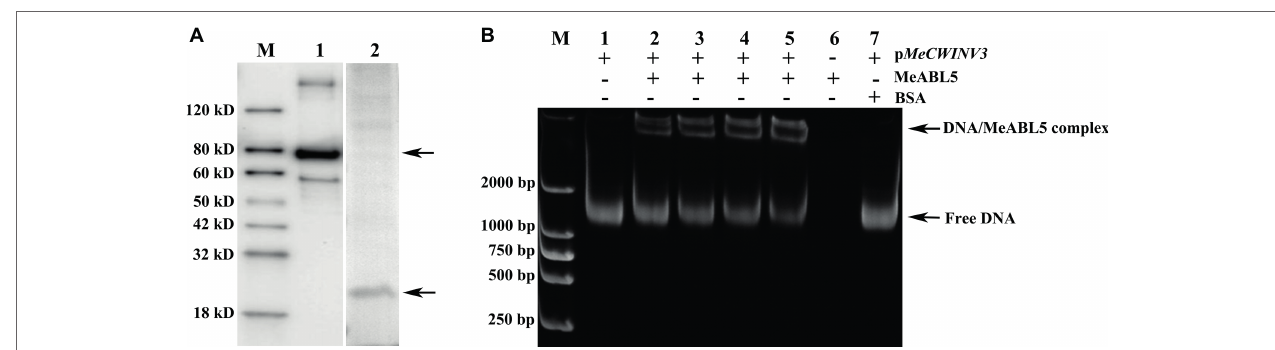
FIGURE 6 | EMSA of the interaction between MeABL5 and the MeCWINV3 promoter. (A) Expression of the MeABL5 protein in E. coli BL21 (DE3). M: Protein marker; Lane 1: the MBP-tagged MeABL5 protein (top arrow). Lane 2: the target MeABL5 protein with the MBP affinity tag removed by TEV protease (bottom arrow). (B) Analysis of the MeABL5 interaction with the MeCWINV3 promoter by EMSA. The promoter of MeCWINV3 with the MeABL5 protein was stained with SYBR Green EMA for visualization of DNA. M: DNA marker. Lane 1: the promoter of MeCWINV3 DNA (500 ng) only; Lanes 2–5: the promoter of MeCWINV3 DNA (500 ng) with increasing amounts of MeABL5 protein (100, 150, 200, and 250 ng); Lane 6: 250 ng MeABL5 protein only; Lane 7: the promoter of MeCWINV3 DNA (500 ng) and 250 ng bovine serum albumin (BSA). The arrows indicate the MeABL5–DNA complex or free